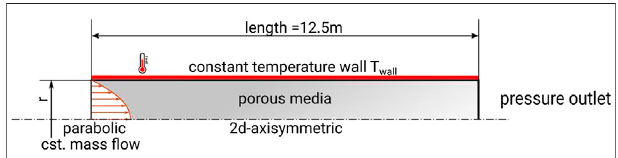
FIGURE2| Schematicrepresentation ofthe fl owsimulationsdomain for a single reforming tube.